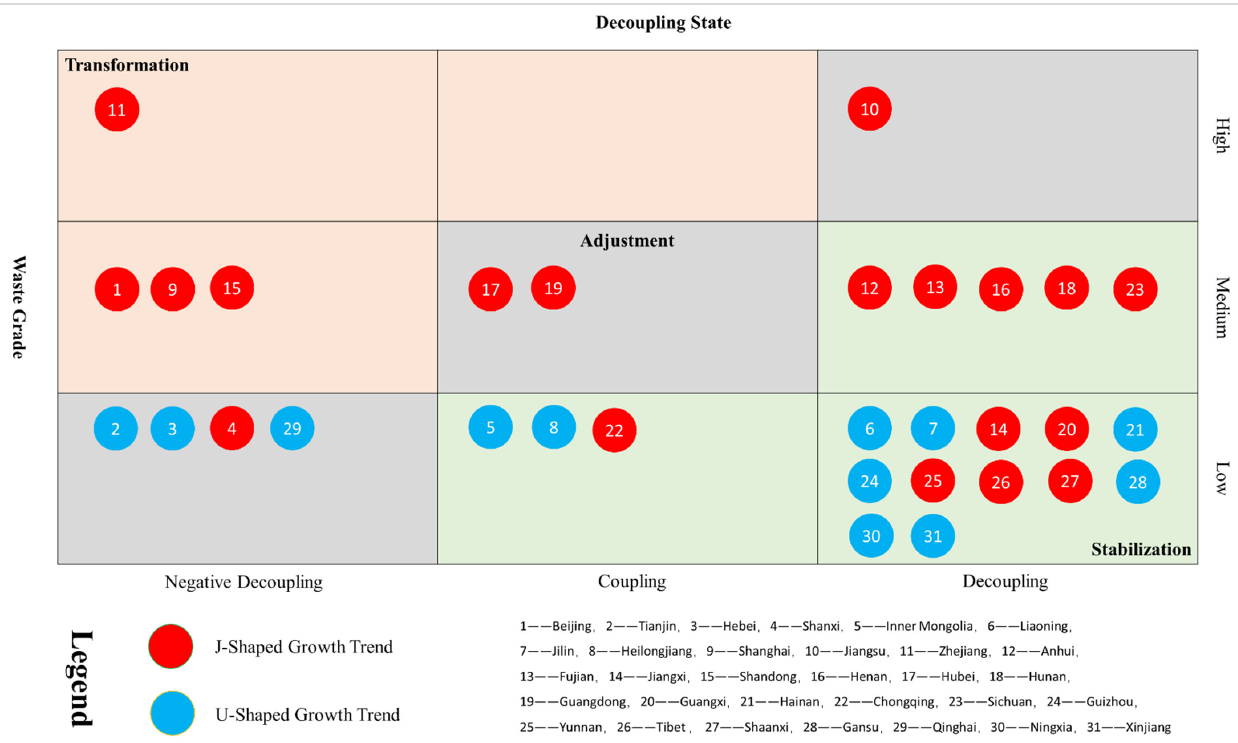
Figure 10. Policy zoning of decarbonization development.